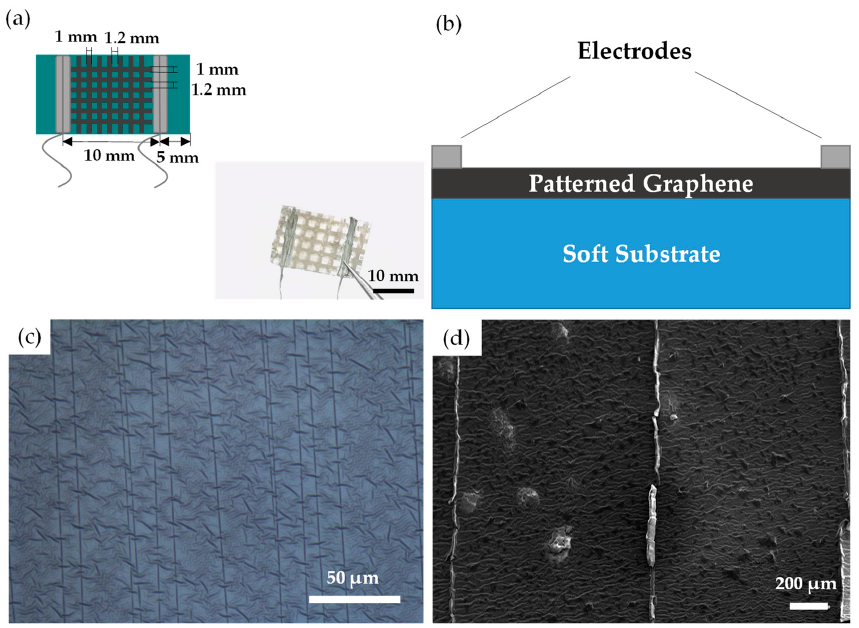
Figure 2. ( a – b ) Photograph and schematic images of the strain sensor using polydimethylsiloxane (PDMS) substrate; ( c ) optical image of PDMS substrate treated by oxygen plasma after 10 pre-stretch cycles (0–10% strain range); ( d ) SEM image of the graphene film on PDMS after 500 loading and unloading (0–1% strain range)